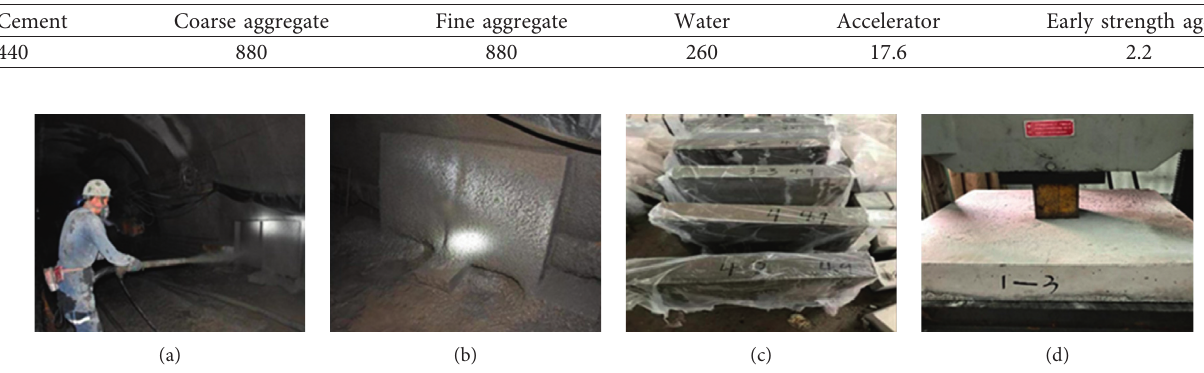
Figure 1: Production of shotcrete specimen. (a) On-site fabrication of square boards. (b) Site maintenance. (c) Demoulding and maintenance. (d) Slab pressing.